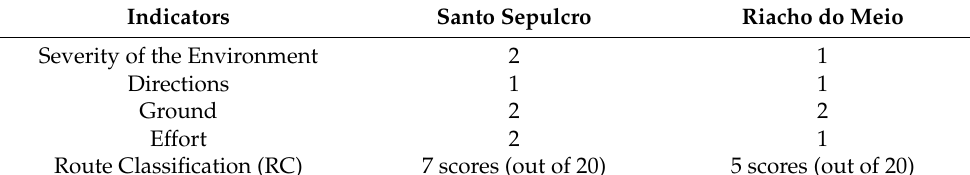
Table 6. Scoring of the Riacho do Meio and Santo Sepulcro trail classification indicators.